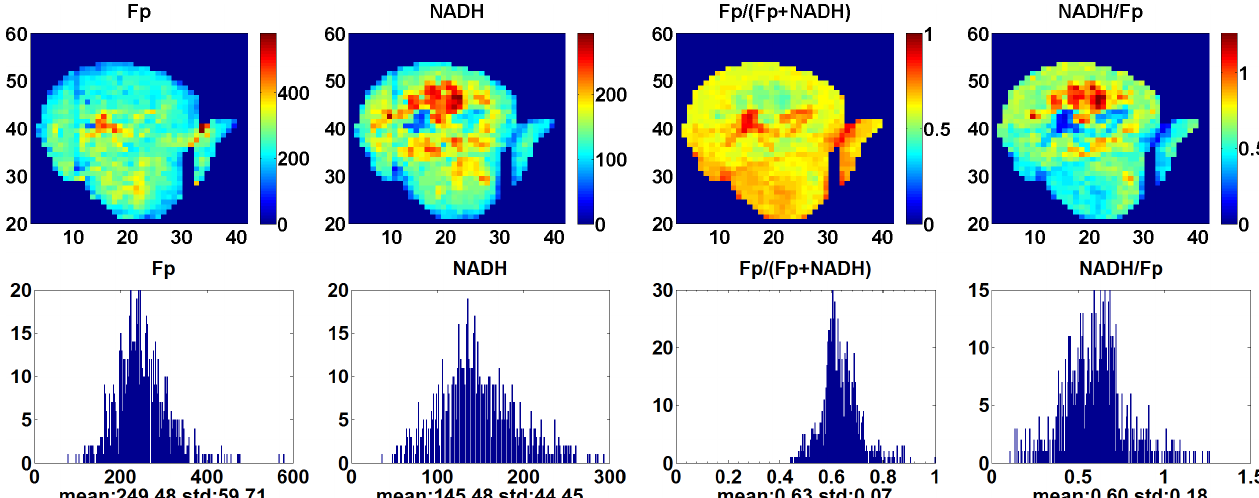
Fig. 2. Typical redox images and corresponding histograms of the p53 wt group. The x and y axes represent the scanning matrix and the color bar is a reference to the colors in the corresponding image. Both Fp and NADH are in the unit of (cid:1) M in reference to the corresponding solution standard of the analytes. The spatial resolution is 200 (cid:1) m and the section depth is 1300 (cid:1) m .